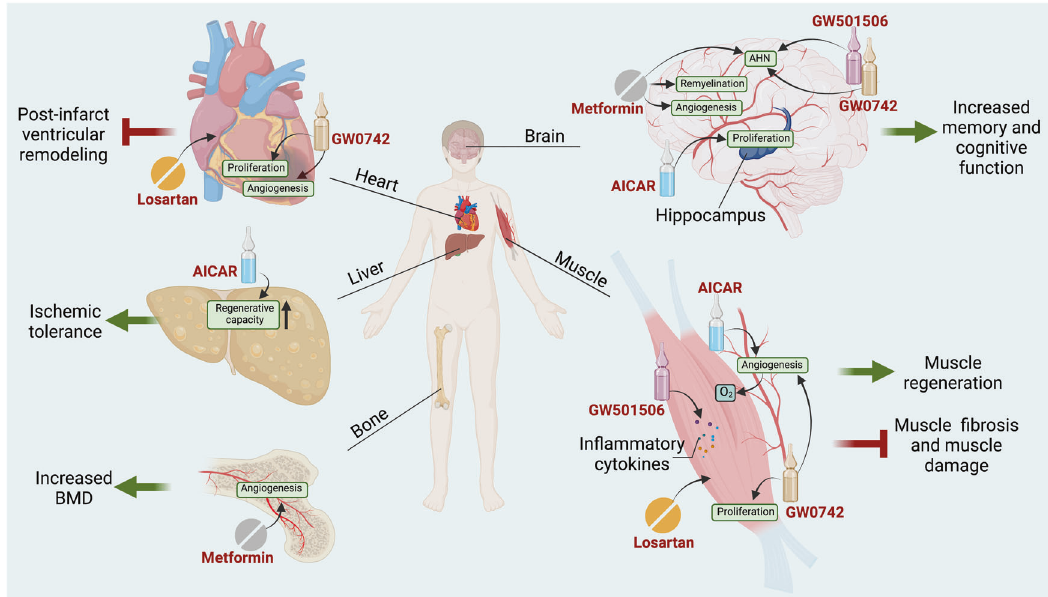
Fig. 7 Emerging pharmaceuticals mimicking exercise-induced tissue regeneration. AMPK/SIRT1/PGC-1 α /PPAR δ pathway has been selected as an important intervention of exercise-induced physiological responses. AICAR, metformin, GW501516, and GW0742, used to mimic exercise- induced physiological responses, demonstrate the ability to promote damaged tissue repair. Additionally, losartan is used to promote muscle regeneration. Created with